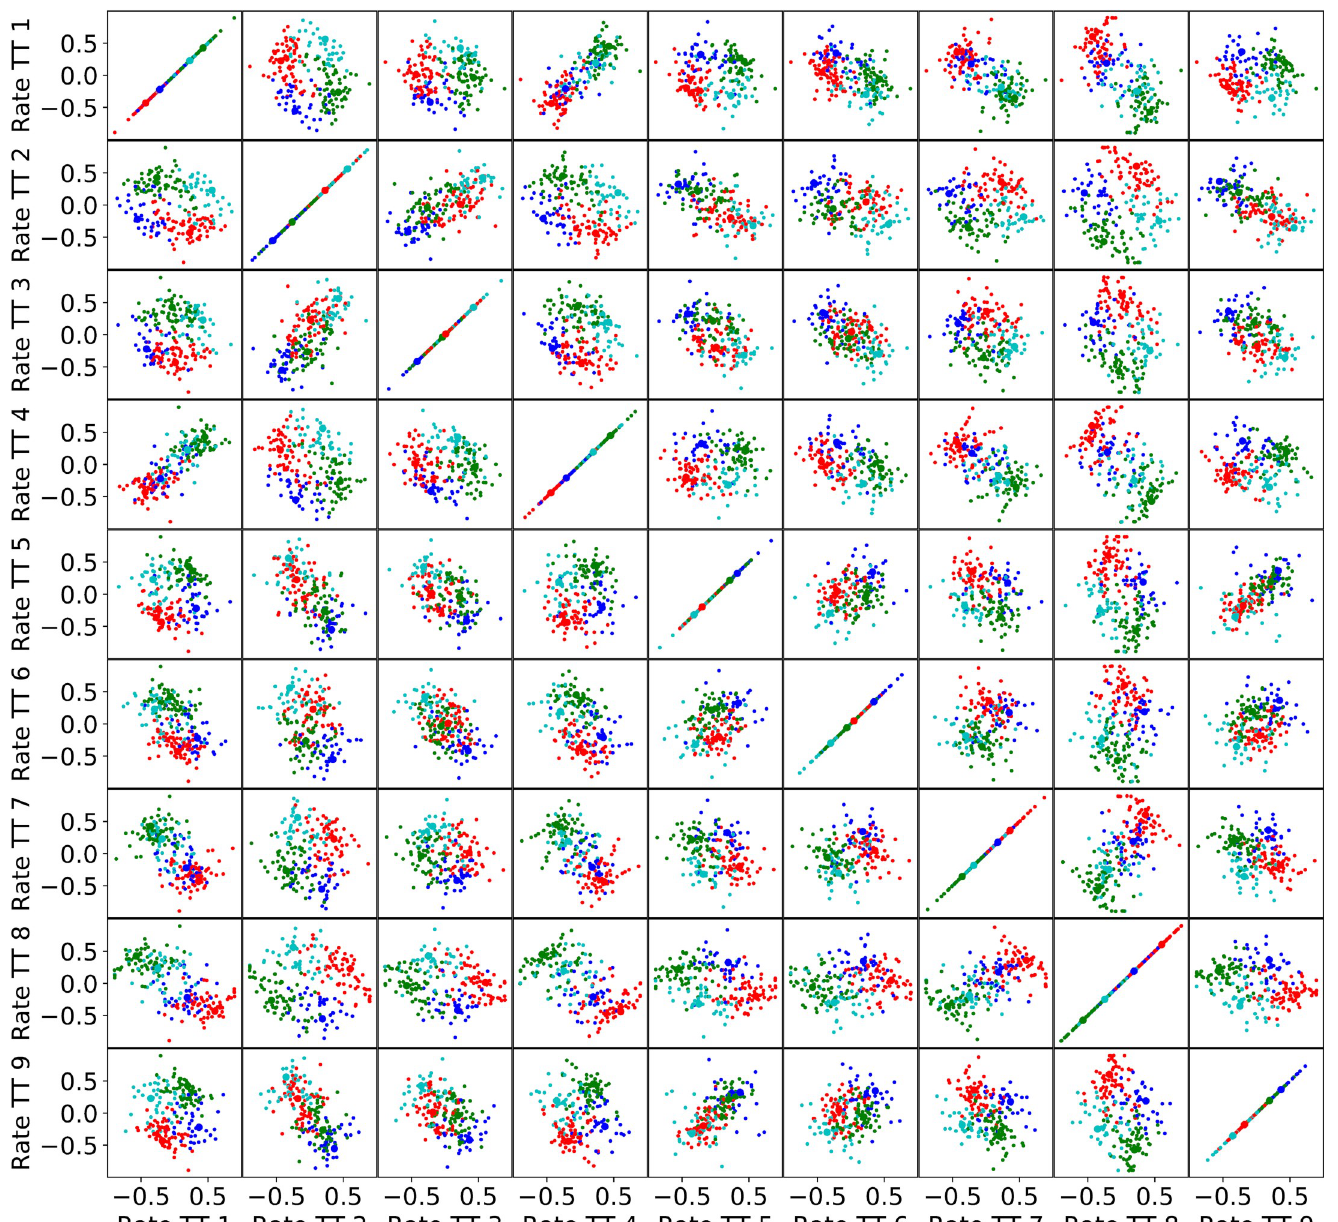
Fig 8. Visualization of four post-juice clusters in the 9-dimensional trial type space. Each color corresponds to one cluster. Each panel shows the centered and normalized firing rates of a pair of trial types and each point in a panel represents a cell from pool 1. Cluster centers are marked with black circles.